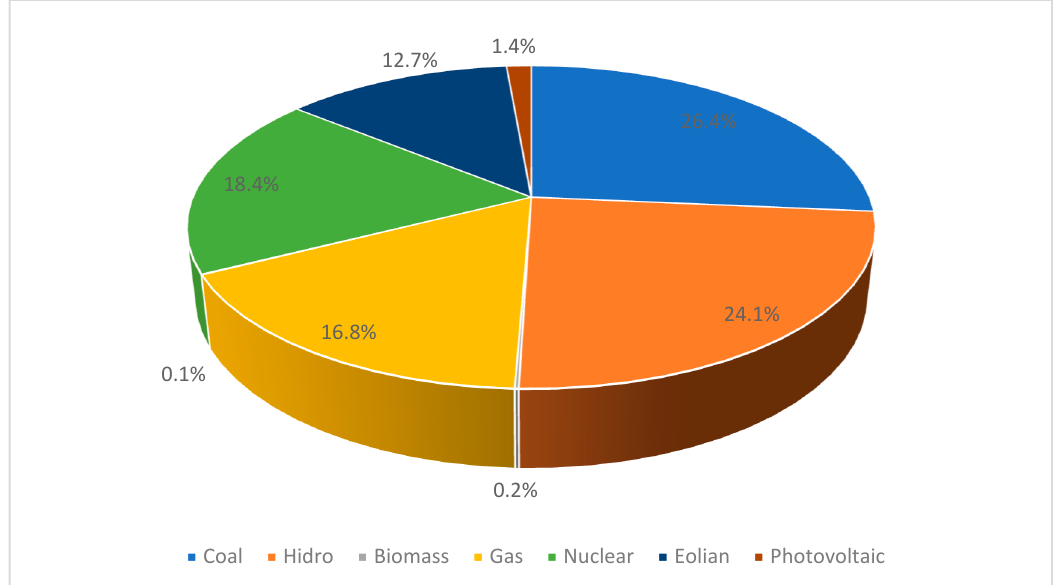
Figure 3. The structure of the energy resource shares in EU, in 2019. Source: authors’ own computations on the data collected from Eurostat [9].